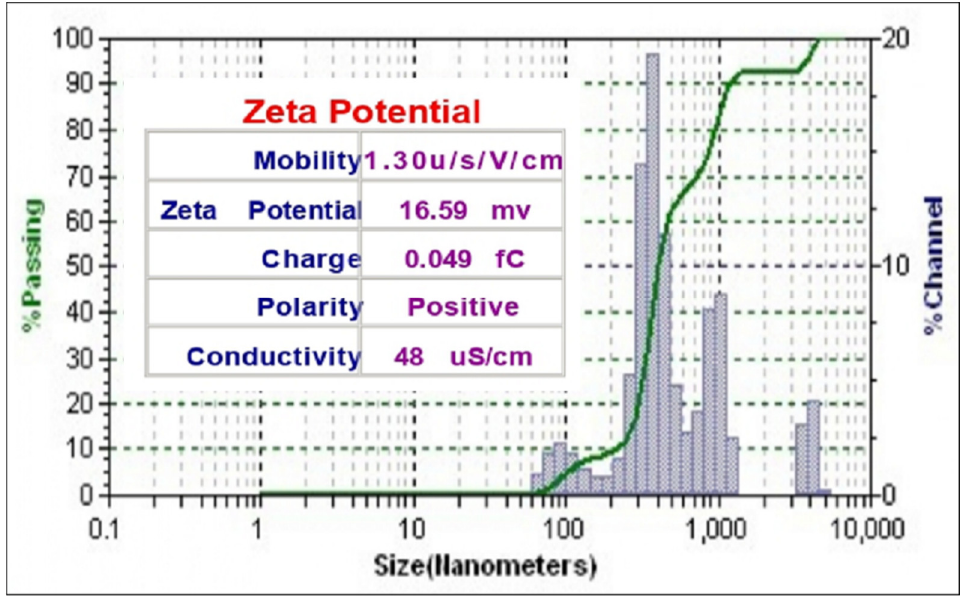
Figure 3. Particle size distribution of ZnONPs.